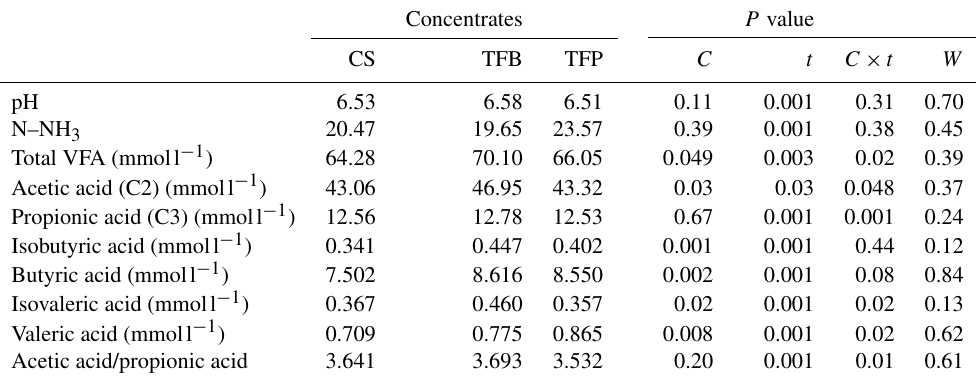
Table 2. Effect of the type of concentrate ( C ), time of sampling ( t ), and their interaction ( C × t ) and the week of lactation ( W ) on pH, ammonia (N–NH 3 ), and volatile fatty acids (VFAs) of ruminal fluid from lactating ewes. Concentrates